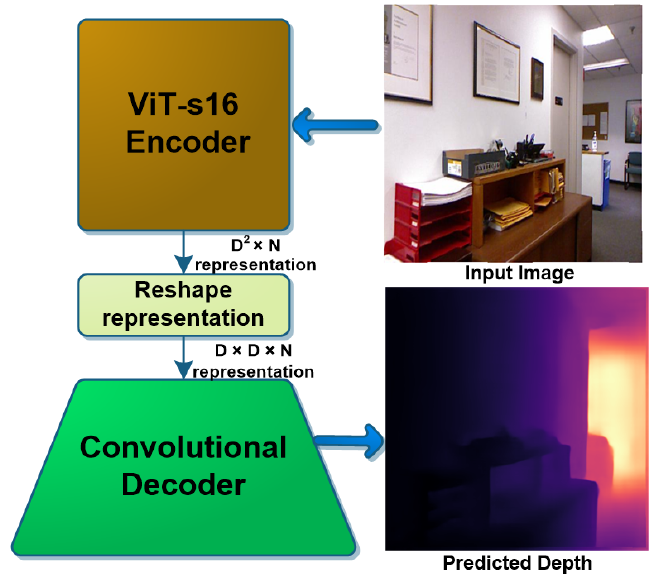
Figure 1. Overview of the proposed encoder-decoder architecture using a ViT encoder and a CNN